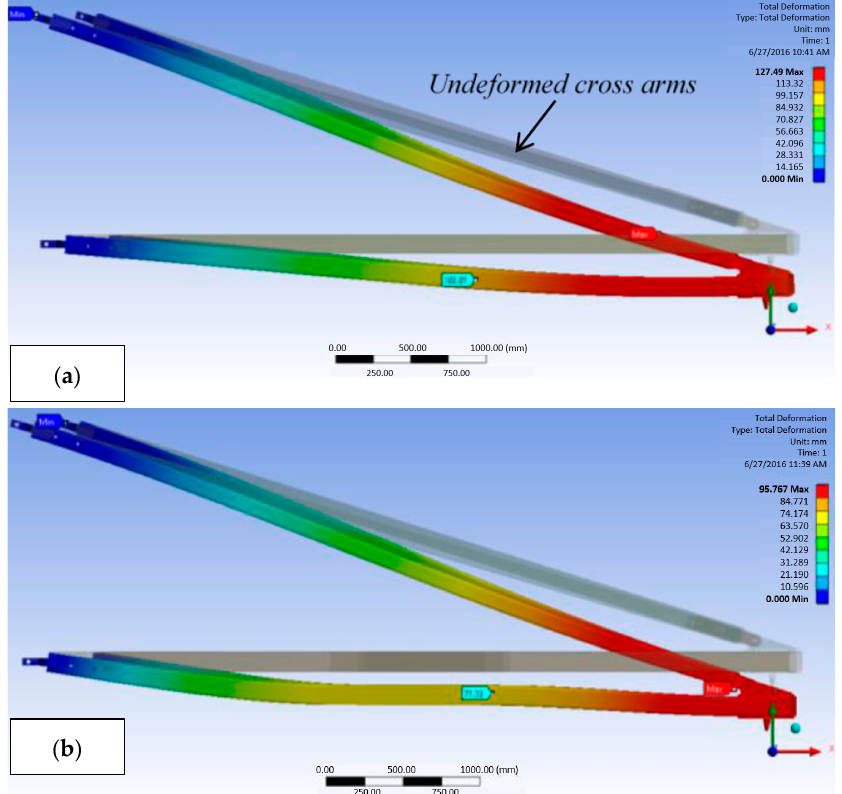
Figure 15. Deformation of ( a ) current composite cross arm, and ( b ) sleeve-enhanced cross arm subjected to multiaxial static loading [2]. Reproduced with copyright permission from Creative Commons Attribution License 3.0. Table 8. Deformation results of both composite cross arm configurations. Reproduce from Ref. [2].